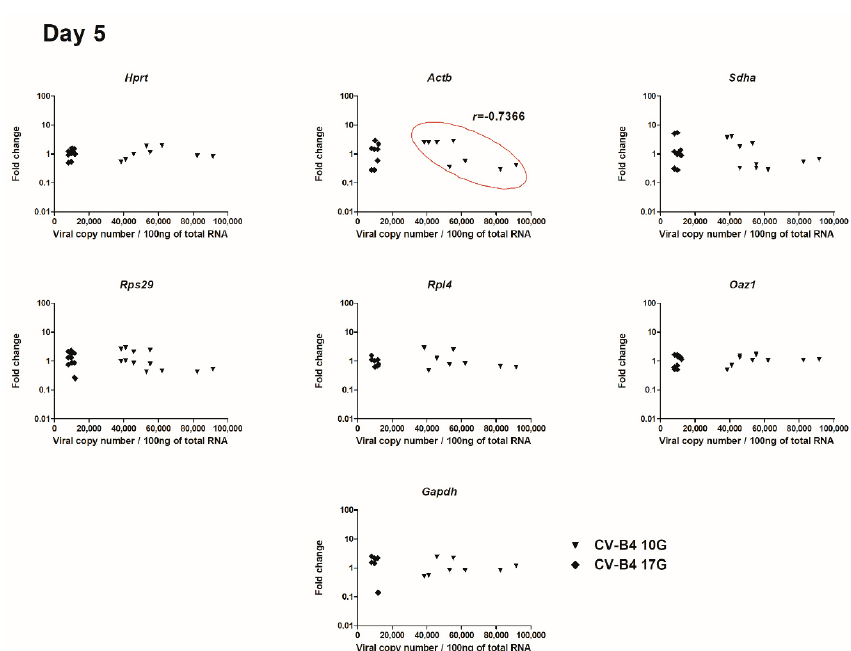
Figure 3. E ff ect of CV-B4 viral load on HKG expression. ( A ). Viral load in infected thymuses. Thymuses ( n = 6–13) were sampled from fetuses at Day 17 of gestation (Day 17G) and from newborns at Day 1 and Day 5 from birth, following an infection at Day 10 or 17 of gestation (Day 10G (cid:72) or 17G (cid:7) ). Total RNA was extracted, converted to cDNA, and the level of viral RNA in the thymus was determined by qPCR and is expressed here as copy number per 100 ng of total RNA. ( B ). Relationship between viral load and fold change in HKG expression in the infected thymus. For each sampled thymus, both fold change in HKG expression and the corresponding viral load were measured and plotted in the same graph. To better assess the e ff ect of infection on HKG expression, a possible correlation between both parameters was evaluated using Pearson’s correlation test. Elliptic forms show negative correlations. r is the Pearson correlation coe ffi cient. Only results for thymuses sampled at Days 1 and 5 from birth are represented here, since those sampled from fetuses at Day 17G showed neither e ff ect of the infection (Figure 2) nor evident correlation with the viral load. CV-B4 10G ( (cid:72) ): thymus sampled from mice born to dams inoculated with CV-B4 at Day 10 of gestation; CV-B4 17G ( (cid:7) ): thymus sampled from mice born to dams inoculated with CV-B4 at Day 17 of gestation.